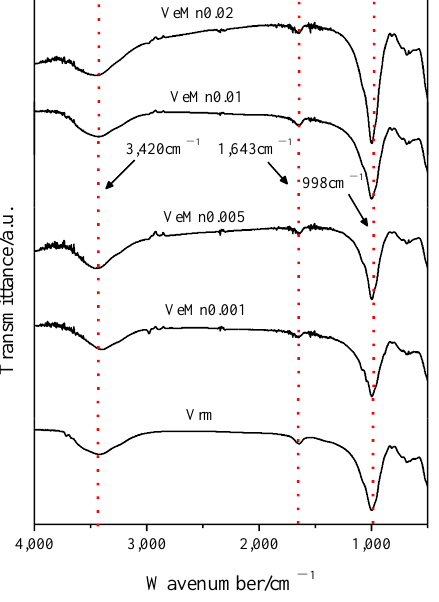
Figure 4. Effect of manganese dioxide on the structure of functional